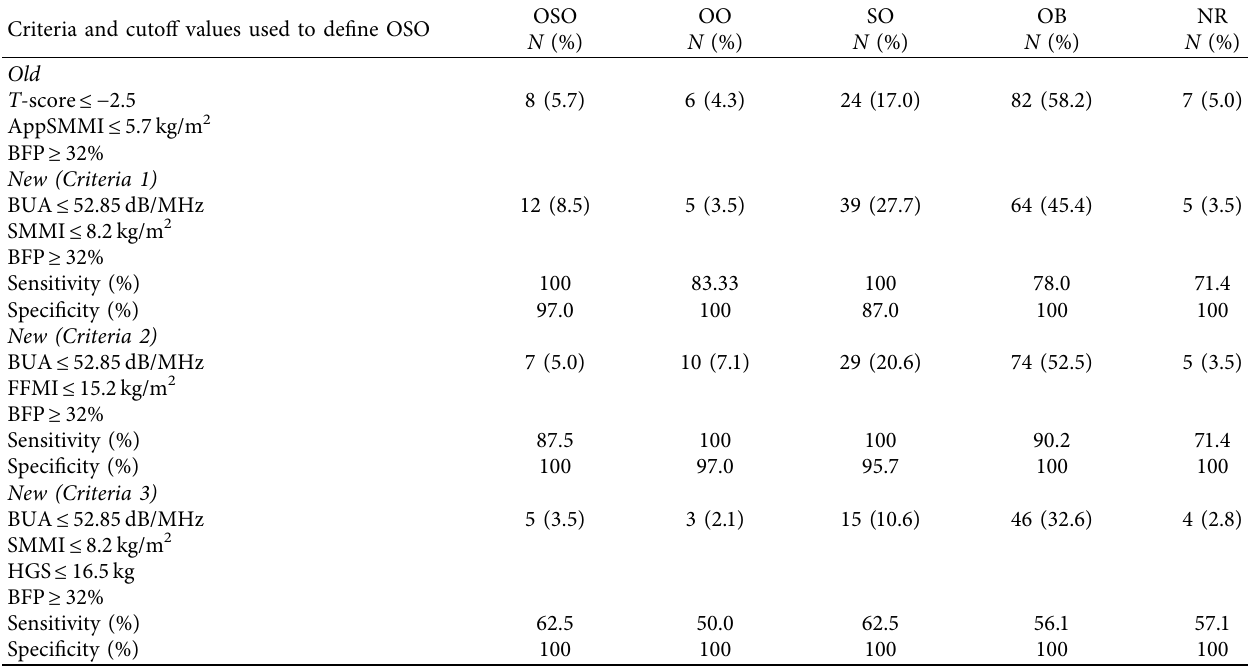
Table 5: Prevalence of OSO and its variations based on the new criteria and cutoff values ( N � 141). OSO OO SO Criteria and cutoff values used to define OSO